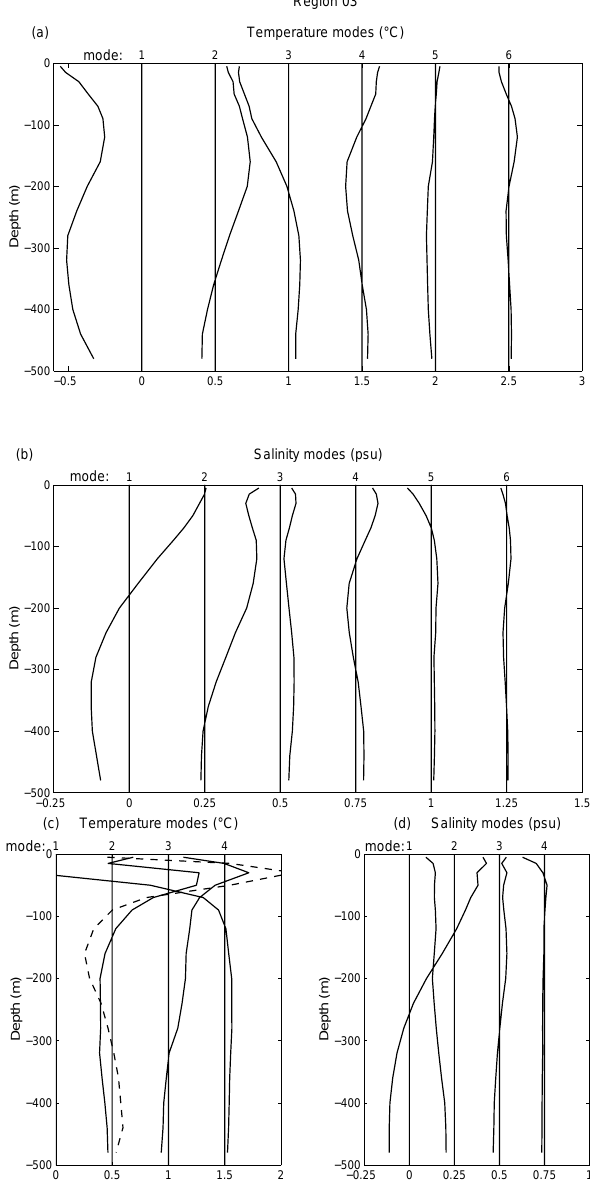
Fig. 7. Vertical EOFs for region 3 (northwestern Basin): (a) tem- perature and (b) salinity modes in winter, and (c) temperature and (d) salinity modes in summer. The first six winter modes and four summer modes are shown. For graphical convenience, a dashed line is used to indicate a change in sign, and respective offsets of 0.5 ◦ C and 0.25psu have been added to each T and S mode for ease of